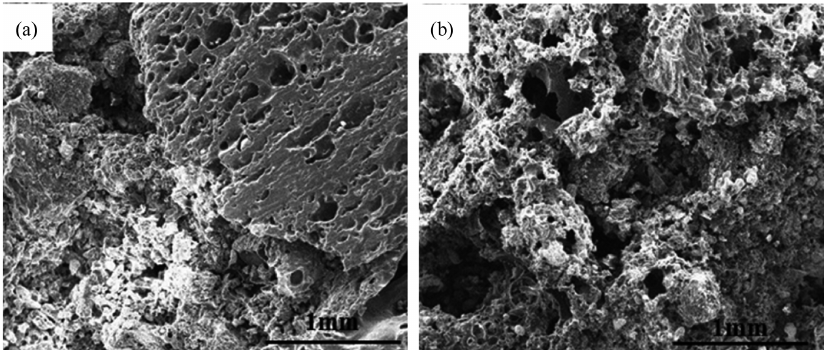
Figure 8: SEM images of ferro-coke sample after the gasification reaction: (a) 30% CO 2 ; (b) 50% CO 2